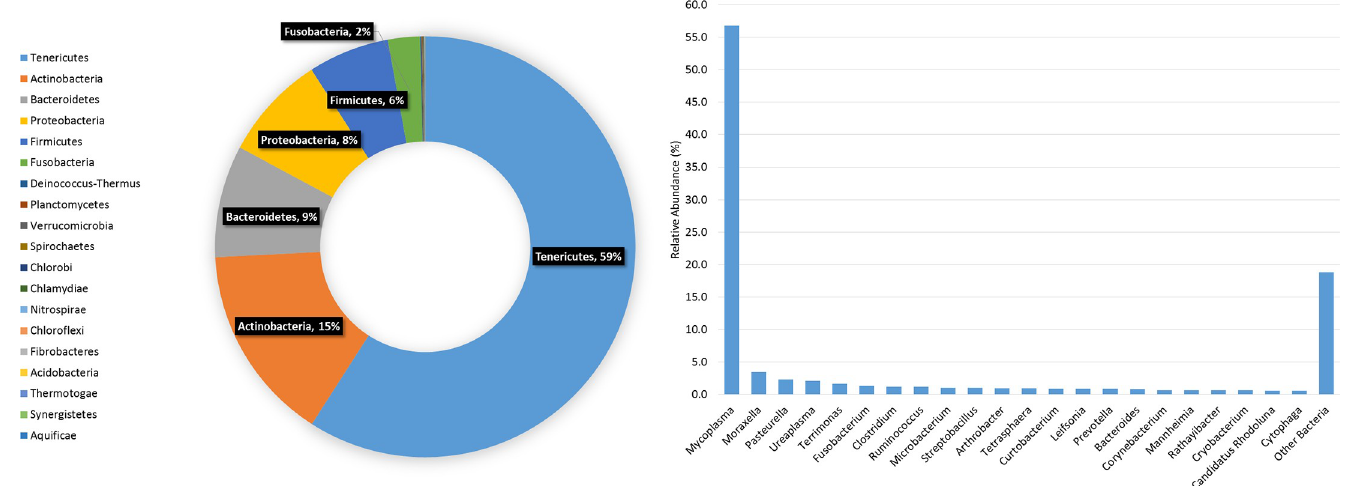
Fig 3. Bacterial taxonomic profile of total 16S rDNA gene sequences in the Bovine URT reference database at the phylum level (donut chart; left) and genus level (bar chart; right). Genus abundances classified by representation at � 0.6% of total sequences.